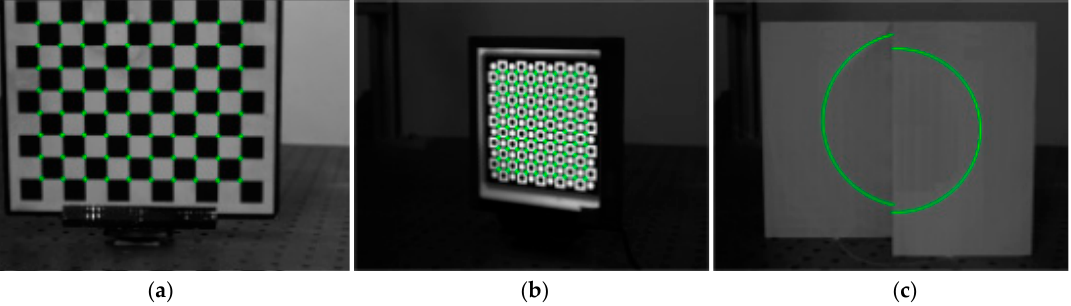
Figure 8. Calibration images based on two methods in the good light environment. ( a ) Calibration images of the normal checkerboard target; ( b ) Calibration images of the light-emitting checkerboard target; ( c ) Calibration images of the double parallel planar target.